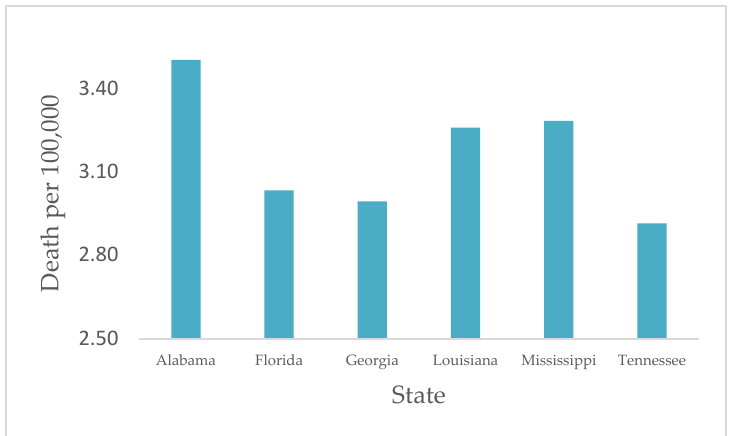
Figure 1. Average cases of COVID-19 by state from January 2020 through February 2022. Highest numbers of COVID-19 cases were observed in TN.